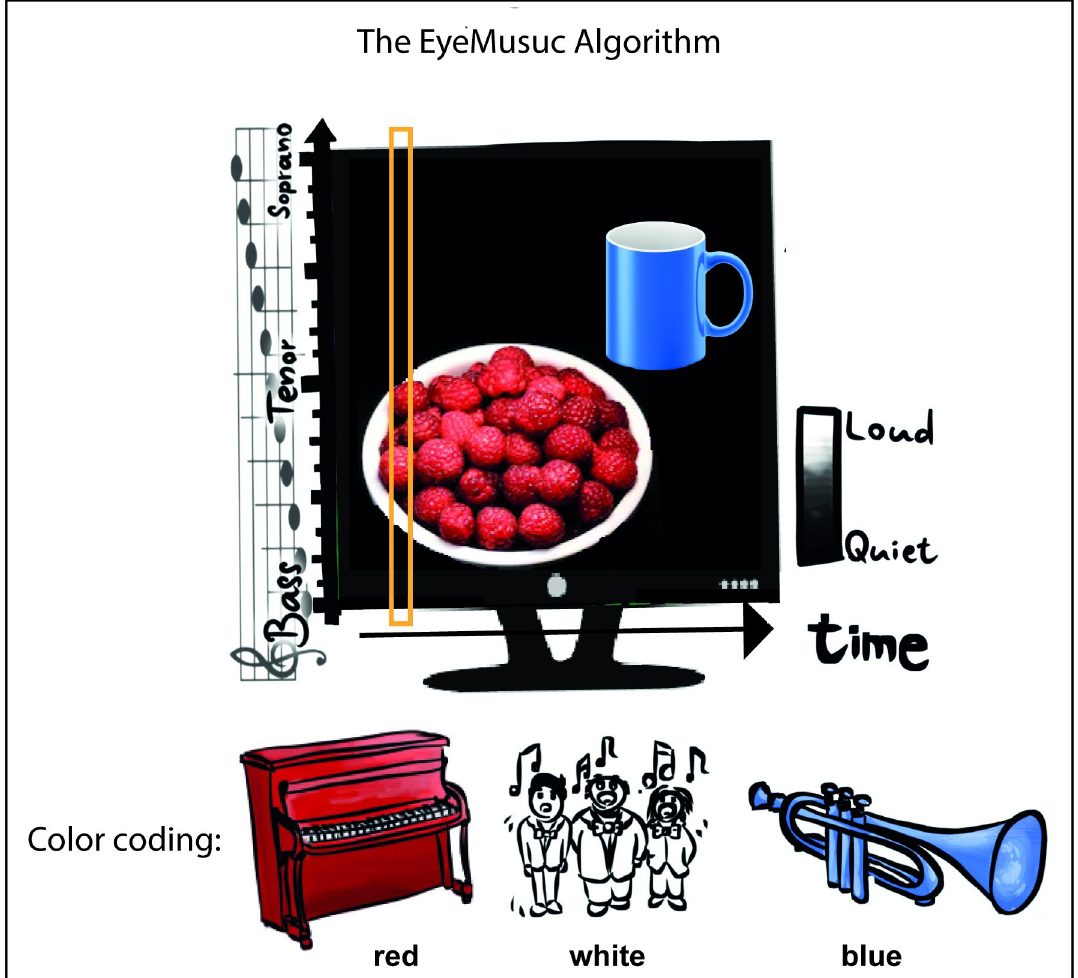
Fig 1. EyeMusic description. The EyeMusic visual-to-auditory SSD transforms visual information into auditory soundscapes. X-axis information is conveyed through time, such that information on the left side of the image is heard before the information on the right. Y-axis information is conveyed through pitch manipulations on the pentatonic scale, such that objects ‘features positioned in the higher portions of the image are sonified with a higher pitch than lower features. Colors are conveyed through timbre variations using different musical instruments. In the current experiment, we used the colors red (piano), white (choir) and blue (trumpet), while silence conveyed black. The orange box, sweeps from left to right, sonifying one column at a time. https://doi.org/10.1371/journal.pone.0250281.g001 PLOS ONE | https://doi.org/10.1371/journal.pone.0250281 April 27,